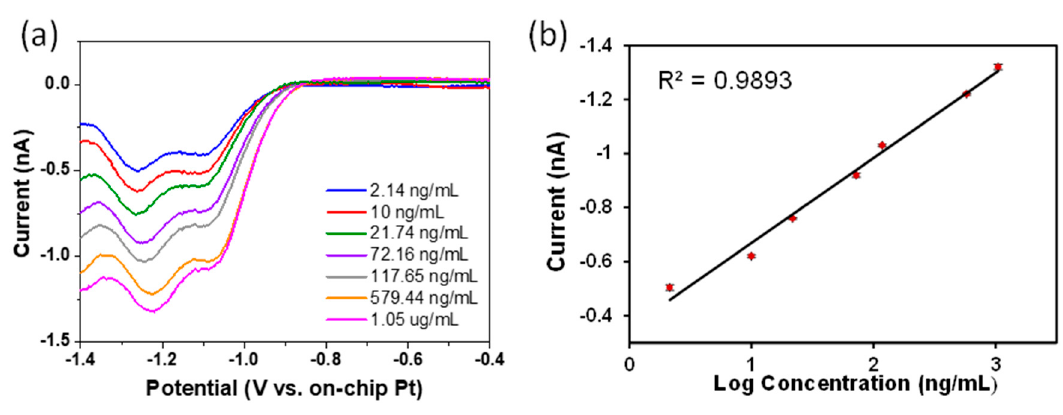
Figure 5. ( a ) SWV of Imidacloprid recorded at different concentrations in acetate buffer (pH 5) versus on-chip Pt pseudo reference electrode. ( b ) Calibration curve of peak current vs. log concentration of imidacloprid. Error bars are included in clear data points.